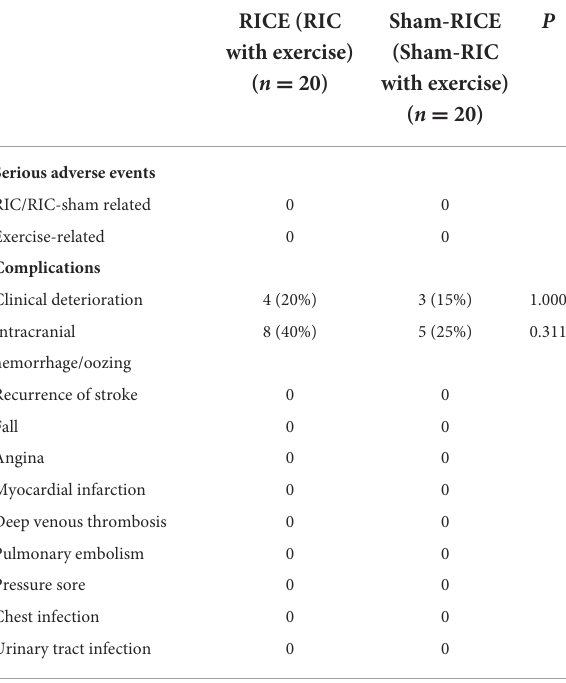
TABLE 2 Primary outcomes (safety) of the patients. TABLE 3 Secondary outcomes (efficacy) of the patients at 90 days.